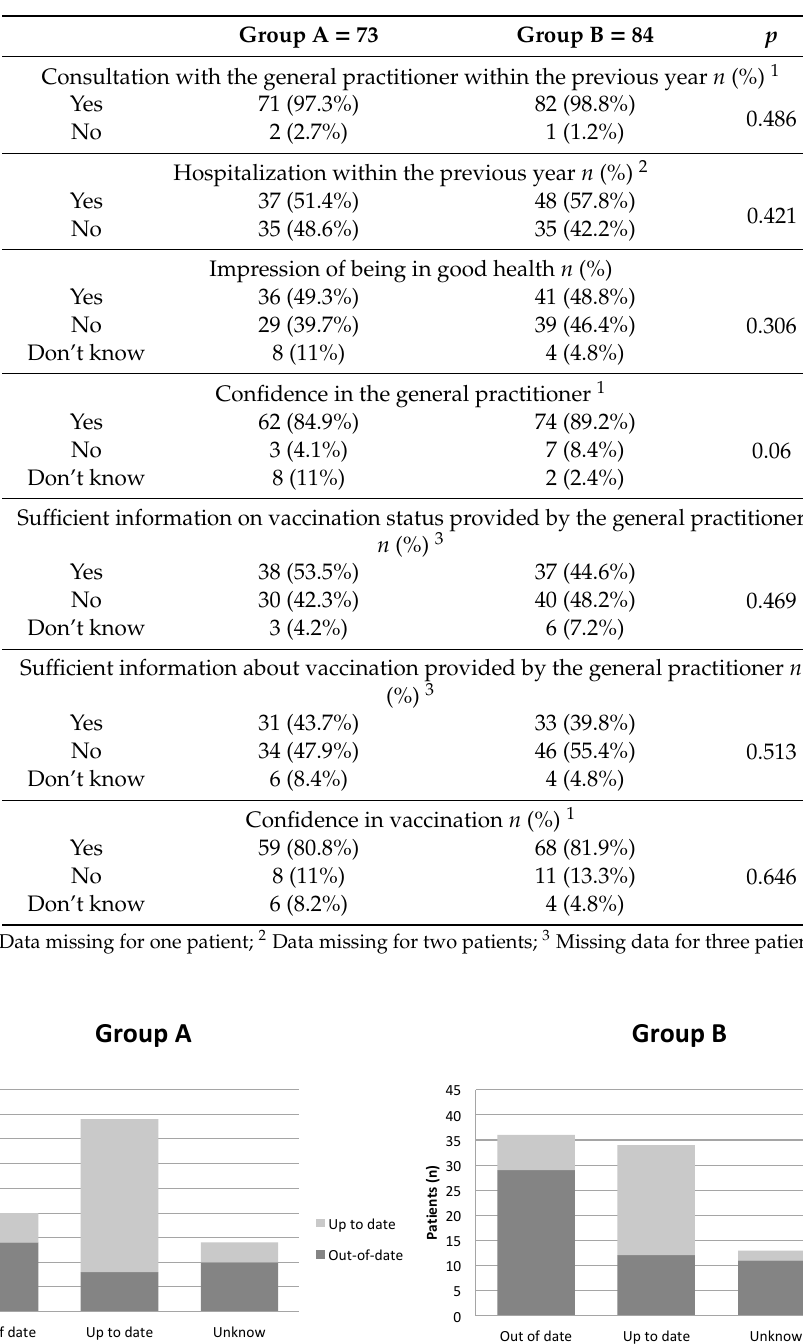
Table 2. Healthcare access in the year preceding inclusion and perception of health and vaccination in patients included in the HOSPIVAC study.